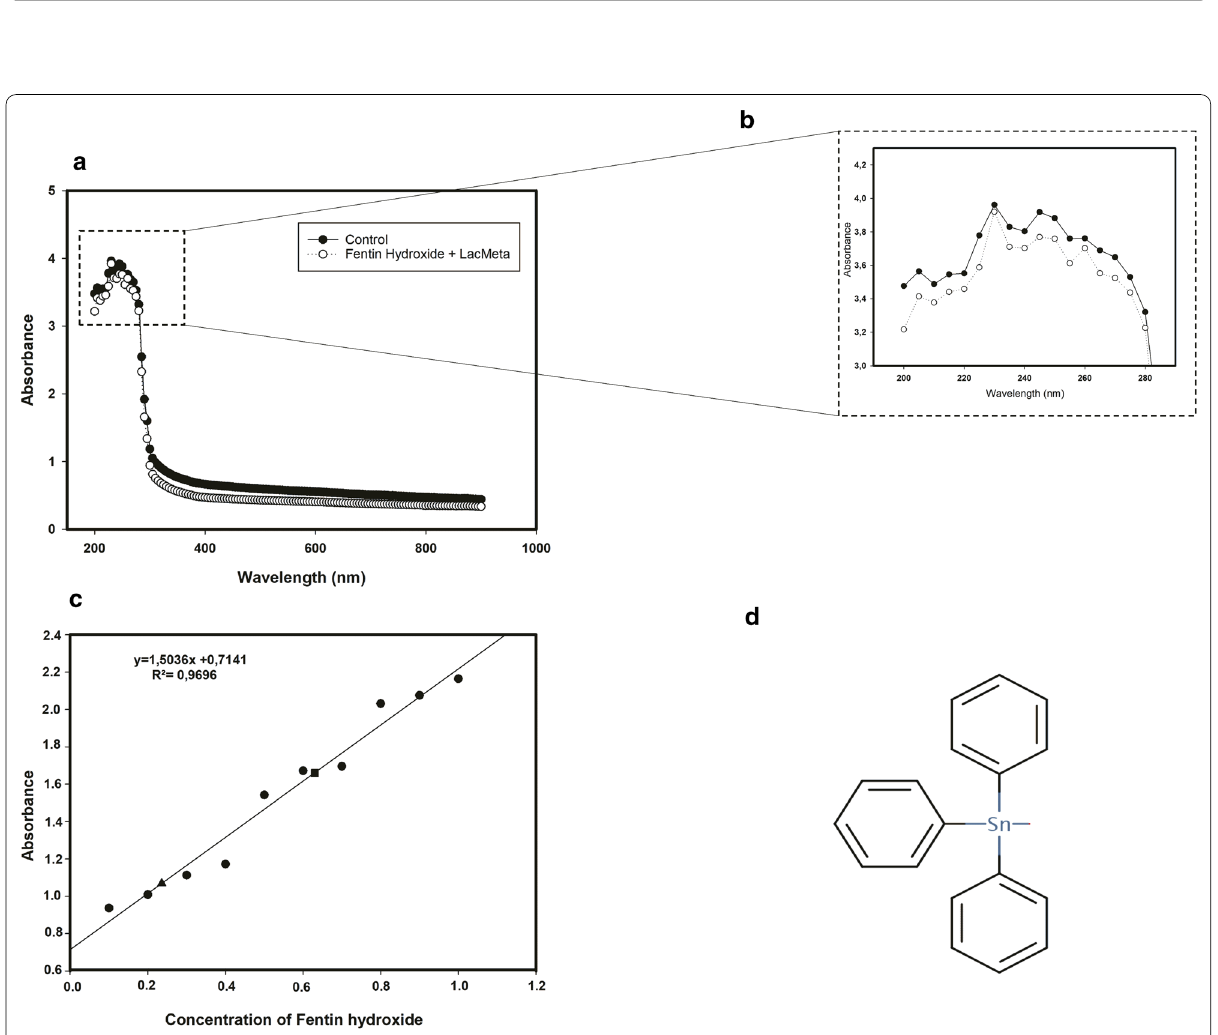
Fig. 8 Effect of LacMeta on degradation fentin hydroxide. a UV–Vis spectra of 200–900 nm. b UV–Vis spectra of 200–280 nm. c Degradation of fentin hydroxide (300 nm). Black triangle: initial concentration; Black square: final concentration after LacMeta treatment. d Chemical structure of fentin hydroxide. Tests were performed for 24 h at 37 °C to 150